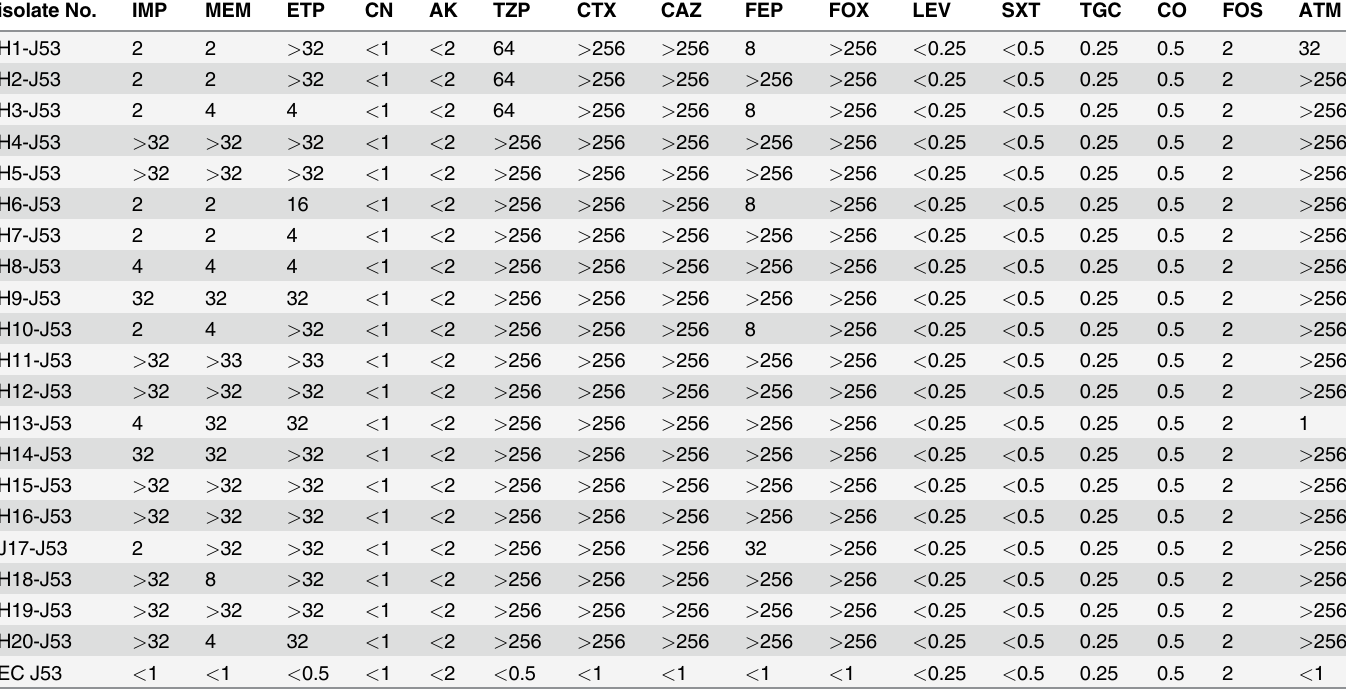
Table 3. The results of antibiotic susceptibility testing of E . coli J53 transconjugant strains derived from blaNDM-producing k . pneumonia transconjugants ( μ g/ml). isolate